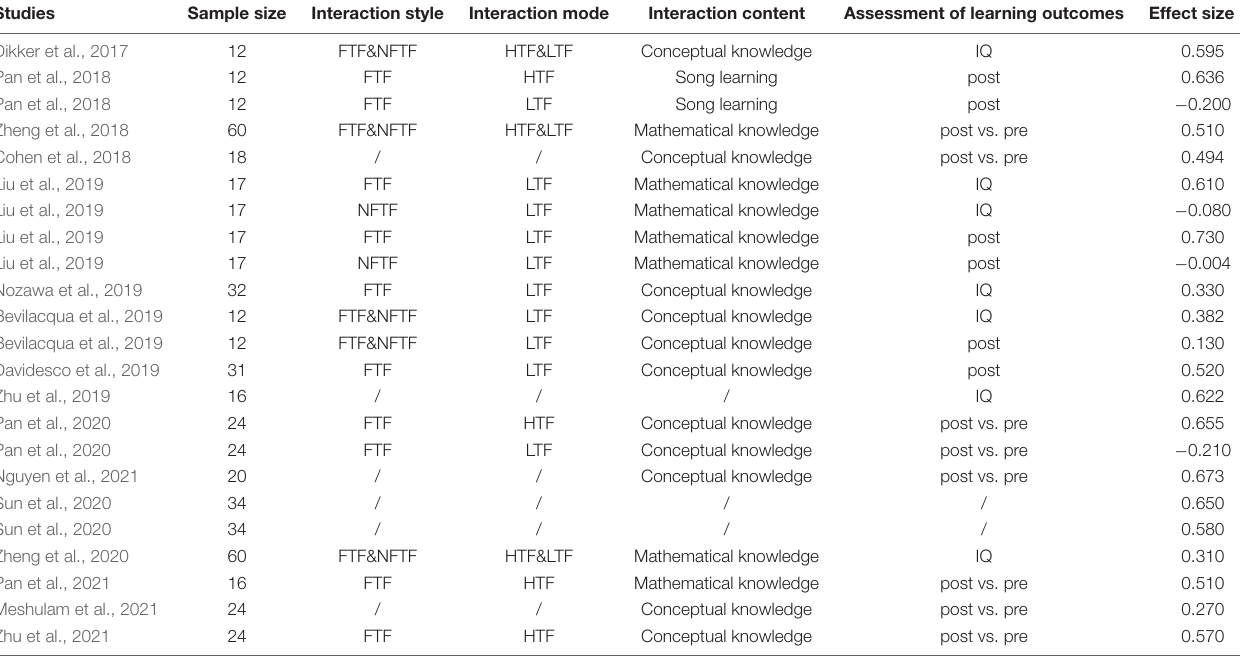
TABLE 1 | Descriptions and characteristics of studies investigating the relationship between INS and learning